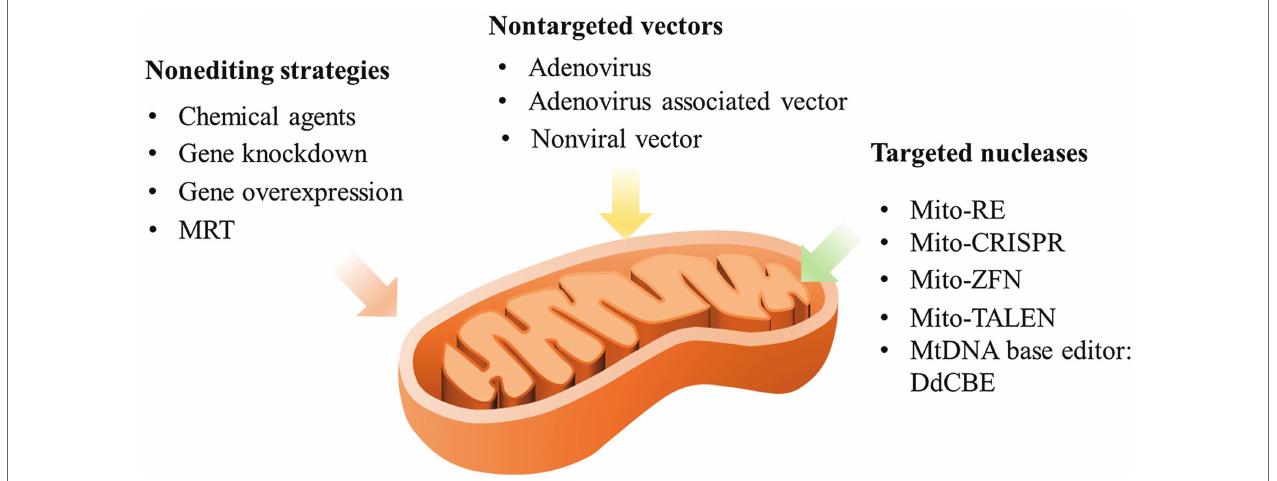
FIGURE 2 | Possible manipulation strategies targeting mtDNA. MRT, mitochondrial replacement therapy; mito-RE, mitochondria-targeted restriction endonucleases; mito-CRISPR, mitochondria-targeted clustered regularly interspaced short palindromic repeats; mito-ZFN, mitochondria-targeted zinc finger nucleases; and mito-TALEN, mitochondria-targeted transcription activator-like effector